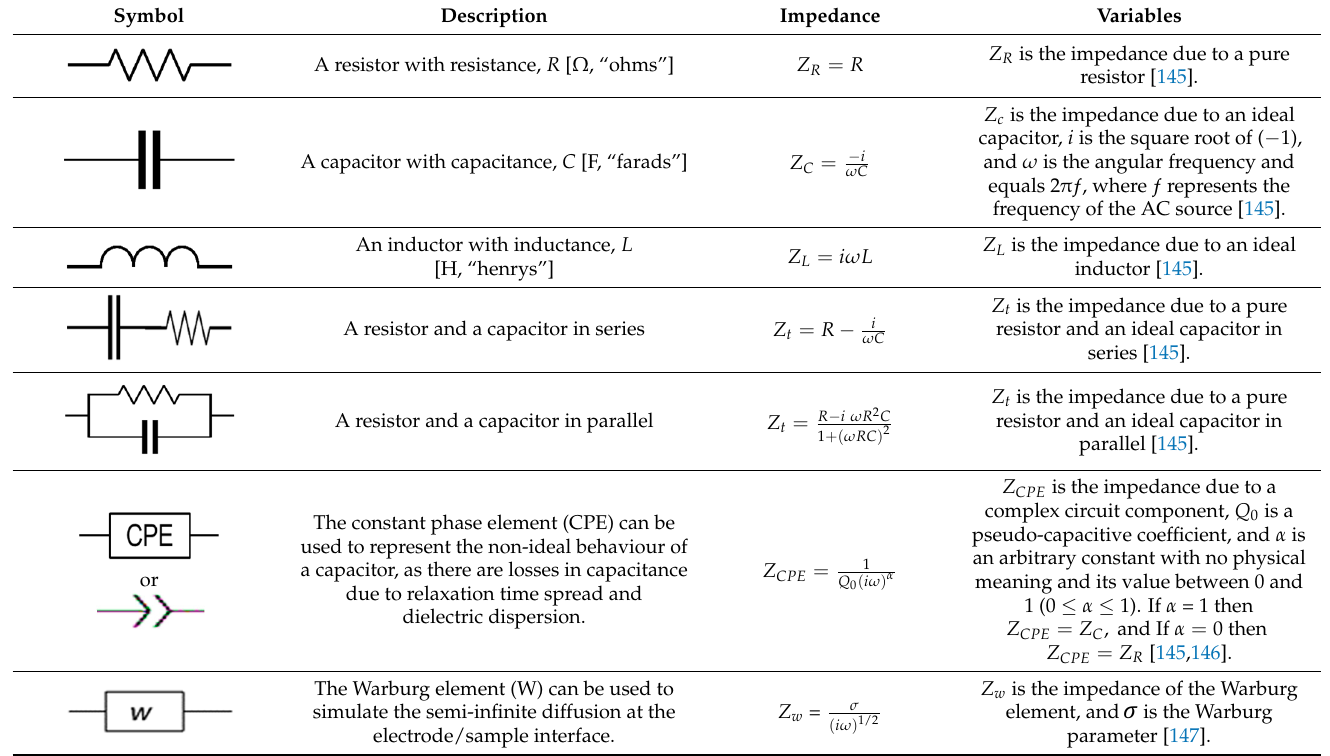
Table 3. Common electrical circuit components of AC circuits.